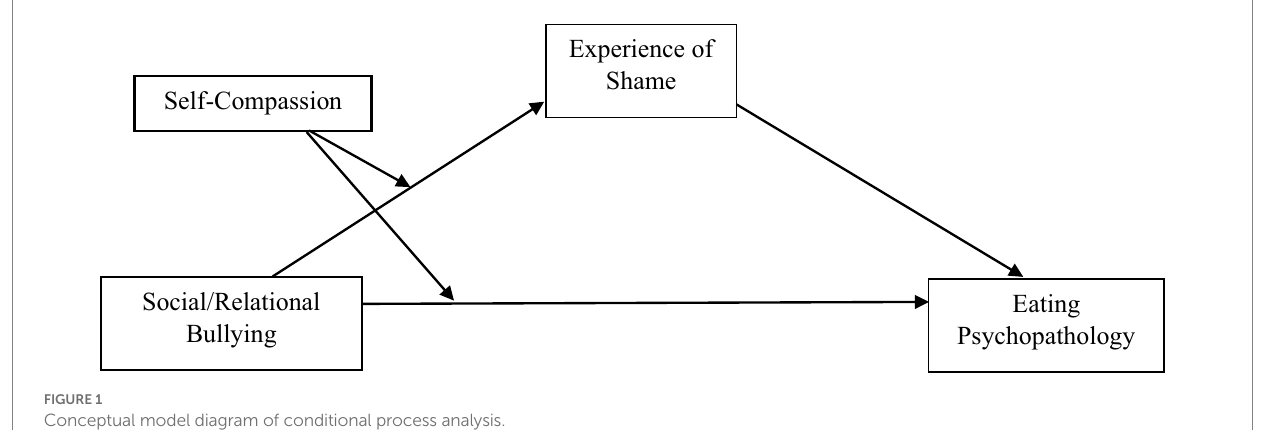
FIGURE 1 Conceptual model diagram of conditional process analysis.